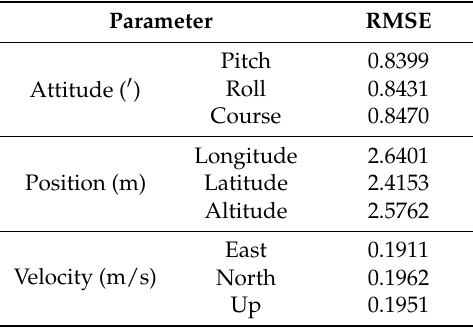
Figure 11. Position error of SINS/SRS/SS integrated navigation system. Table 4. Positioning errors of SINS/SRS/SS integrated navigation